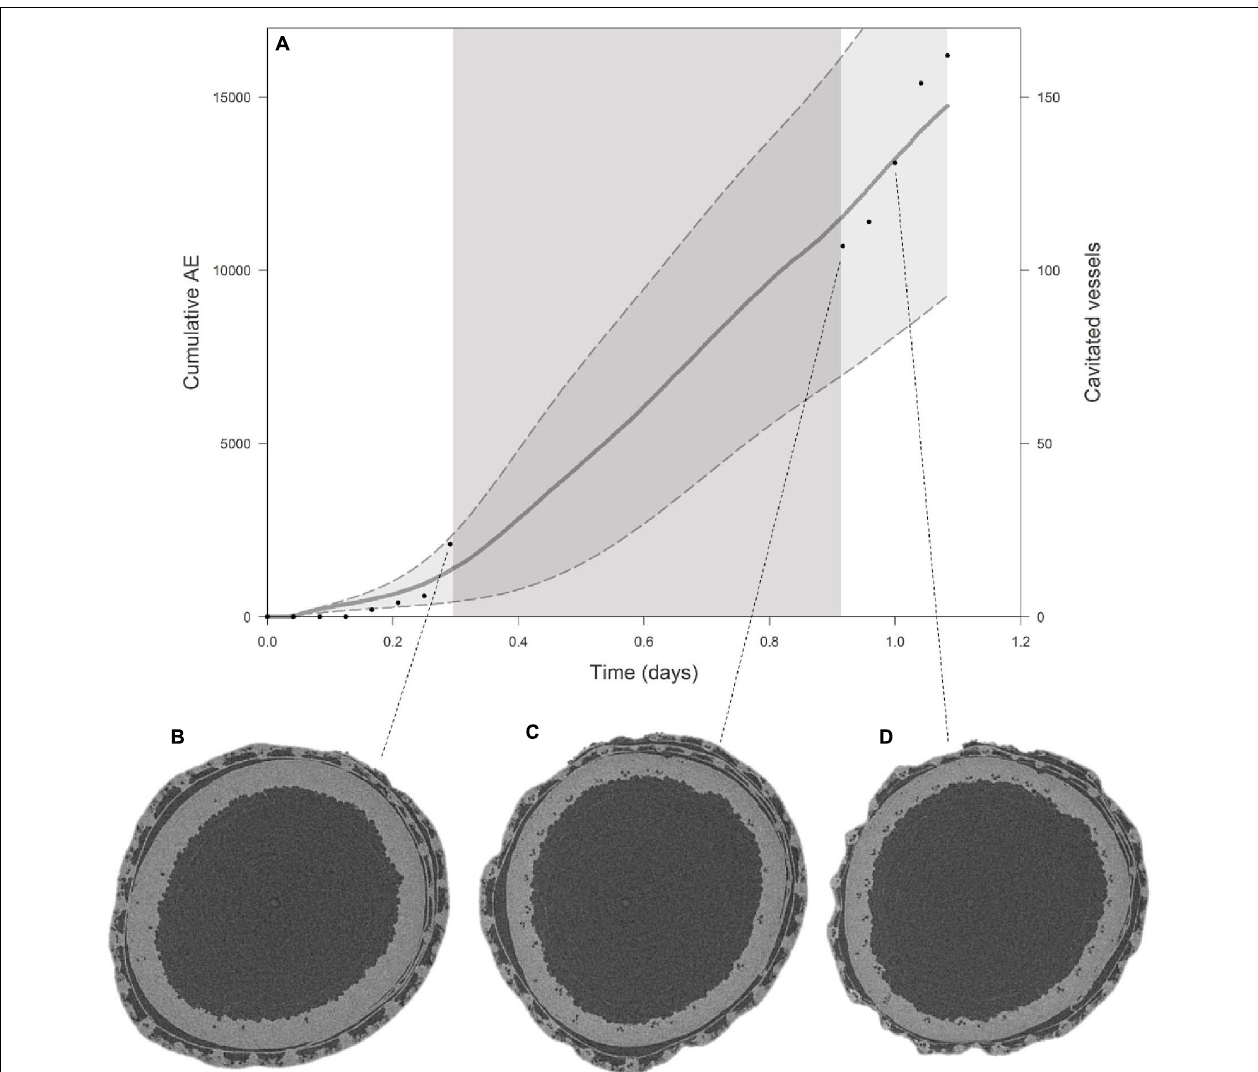
FIGURE 4 | (A) Average cumulative AE with standard error bands (gray curve, left y -axis) for Excalibur shows a similar pattern to the number of embolized vessels (black dots, right y -axis) counted on EMCT images when plotted against time. The dark gray zone in the curve depicts the night hours, when no images could be taken. The EMCT cross-sections for the stem at which 12% (B) , 50% (C) , and 88% (D) of the vessels are embolized are shown. Embolized vessels, filled with air, appear as small black dots on the EMCT cross-sections.